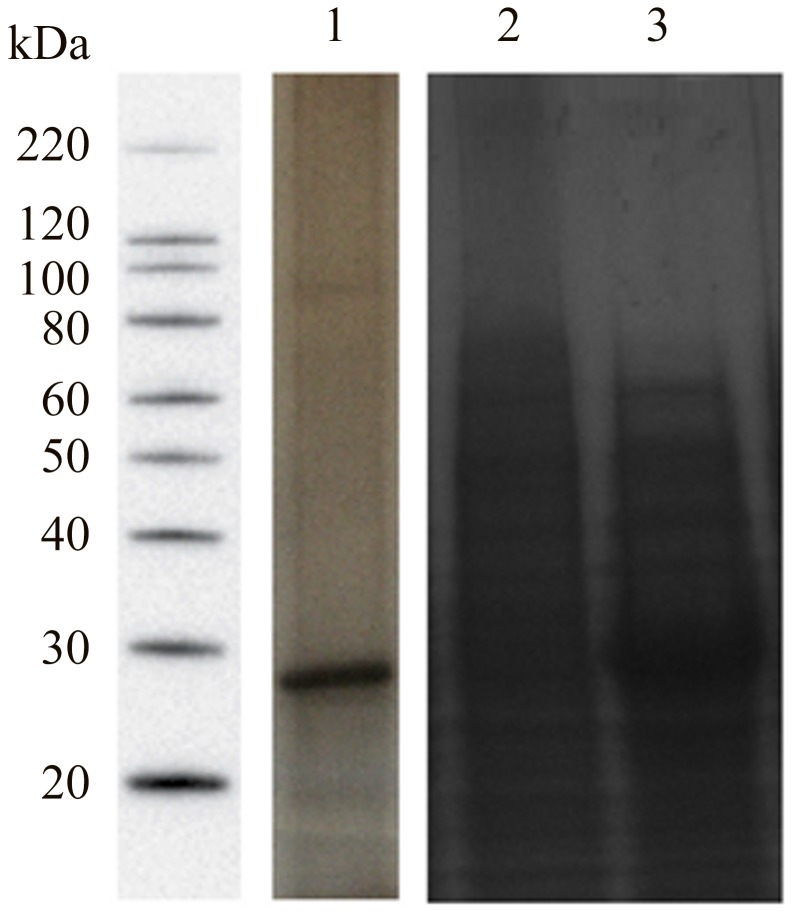
SDS-PAGE analysis of the “crude antigen” and the protein chain of recombinant CCA.Aliquots of samples corresponding to the final product of adult worm extract submitted to purification steps (2) and, the CCA recombinant protein expressed in E. coli before (3) and after (4) induction with IPTG were subjected to silver stained SDS-PAGE analysis. Electrophoresis was done using 12% Tris-glycine gels. Molecular weight standards are shown in (1).